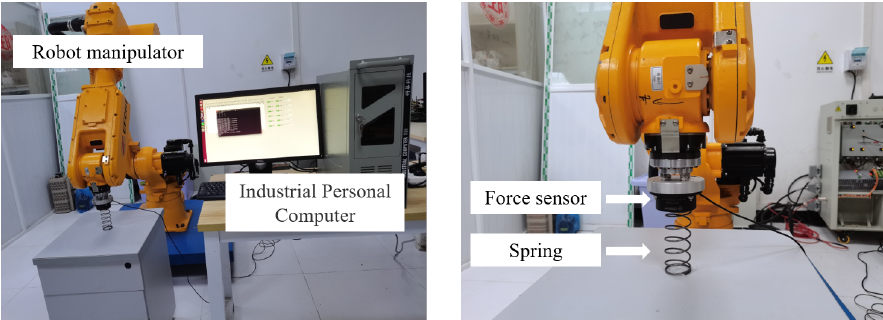
Figure 13. The experimental